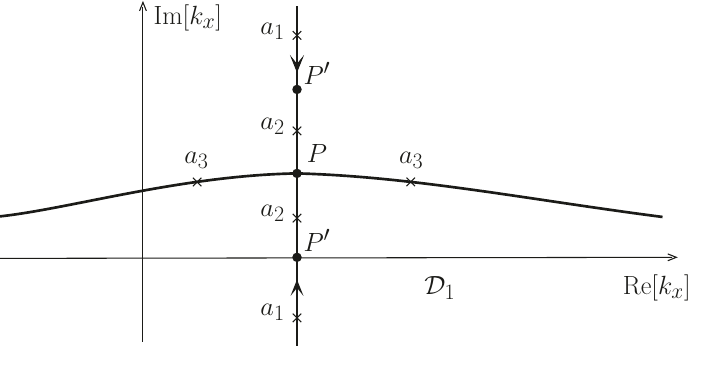
Figure 7 . Solutions (3.1) for Im[ p 0 ] =